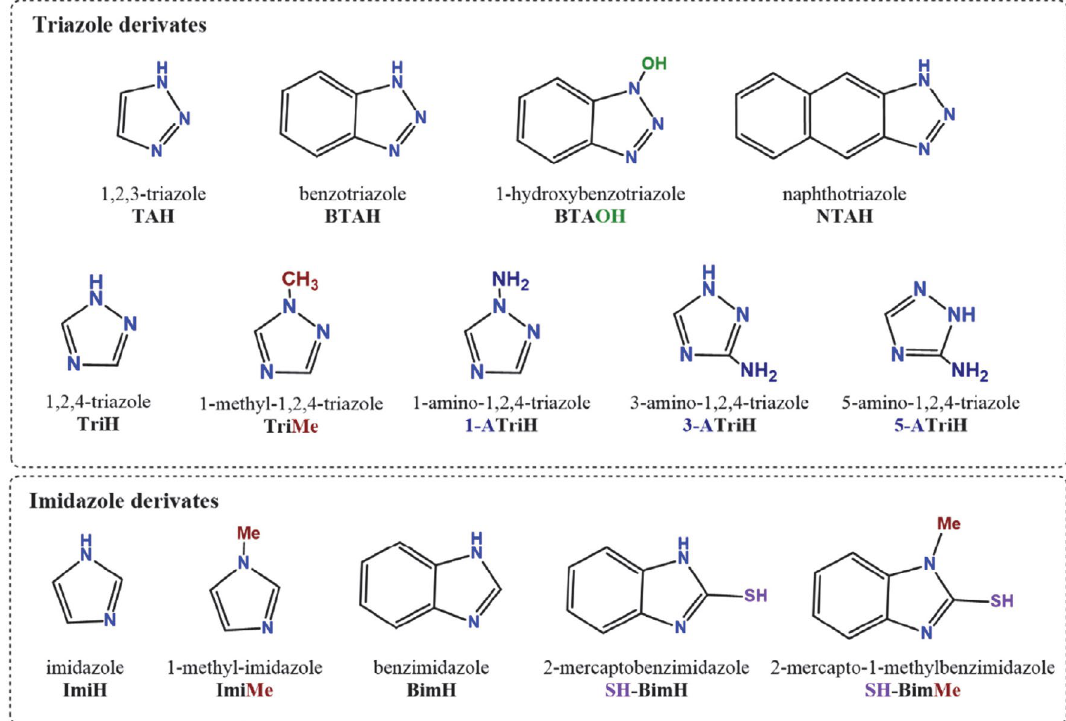
Figure 6. Skeletal formulae of triazole and imidazole derivatives used as corrosion